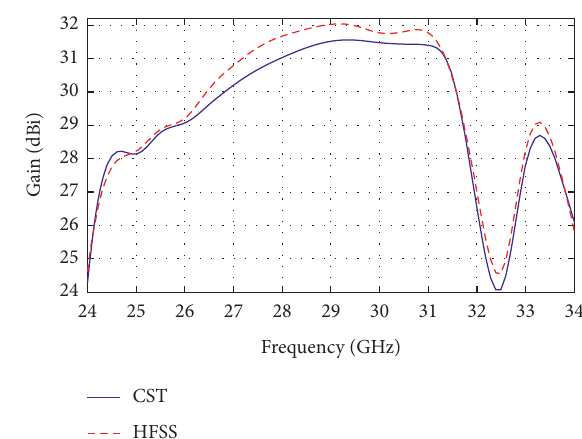
Figure 17: Simulated gain of the 16 × 16 CP array